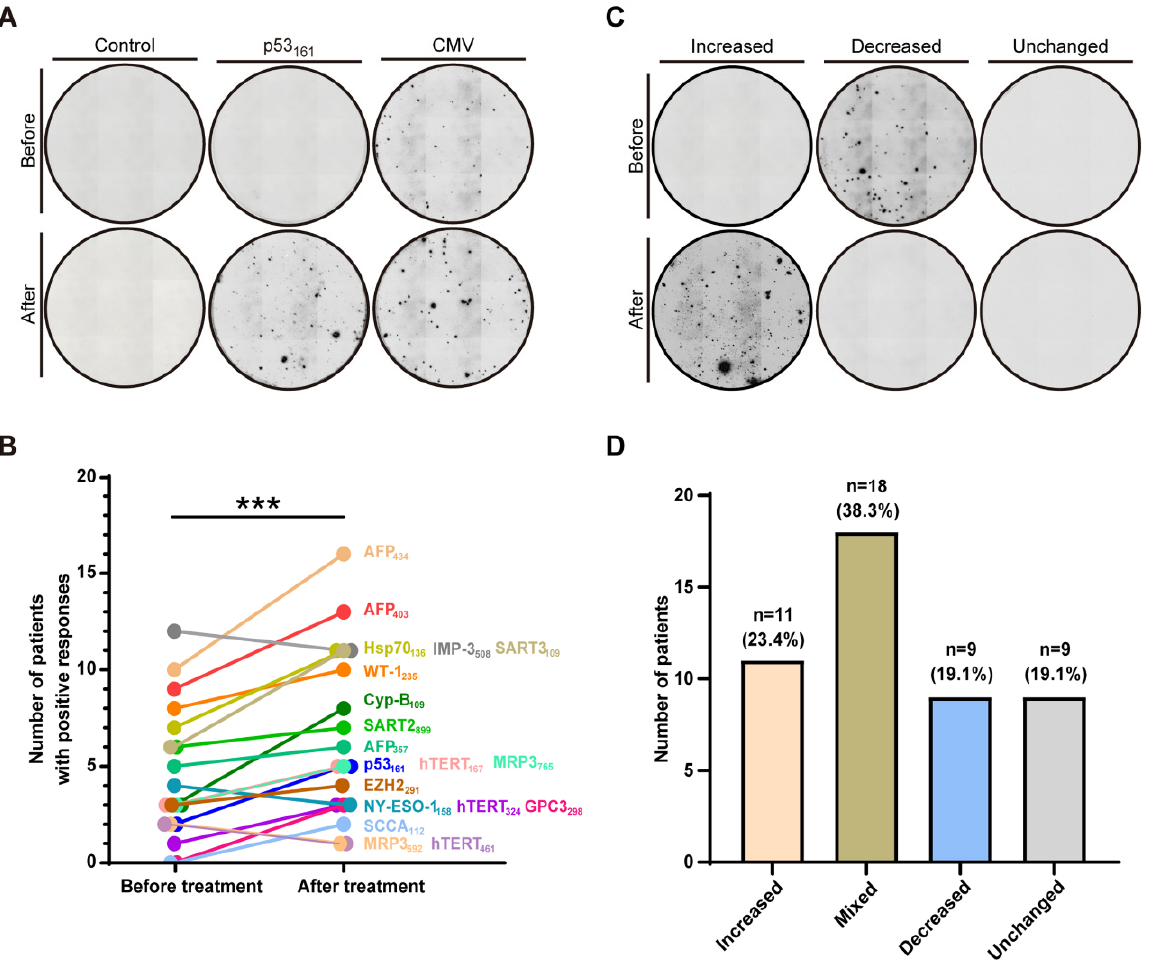
Figure 1. HCC-related TAA-derived peptide-specific immune responses. ( A ) Representative images of IFN- γ ELISPOT assay testing PBMCs stimulating and unstimulating with TAAs (figure shows p53 161 ) as well as before and after antiviral therapy. The IFN- γ ELISPOT assay was performed to examine immune responses to 19 TAA-derived and CMV pp65 control peptides in 47 patients before and after the treatment with DAAs. ( B ) Dot plot showing the number of patients with a positive response to each TAA-derived peptide before and after the treatment with DAAs, detected by the IFN- γ ELISPOT assay. The paired t -test was used to calculate p values. ( C ) Representative images of the IFN- γ ELISPOT assay showing significant increase, significant decrease as well as unchanged response. ( D ) The number of patients showing four different patterns of changes in the frequency of T cells specific for TAA-derived peptides after the treatment with DAAs. Patients were categorized into the following four groups, as described in the Materials and Methods: increased group (n = 11), mixed group (n = 18), decreased group (n = 9), and unchanged group (n = 9). *** p <